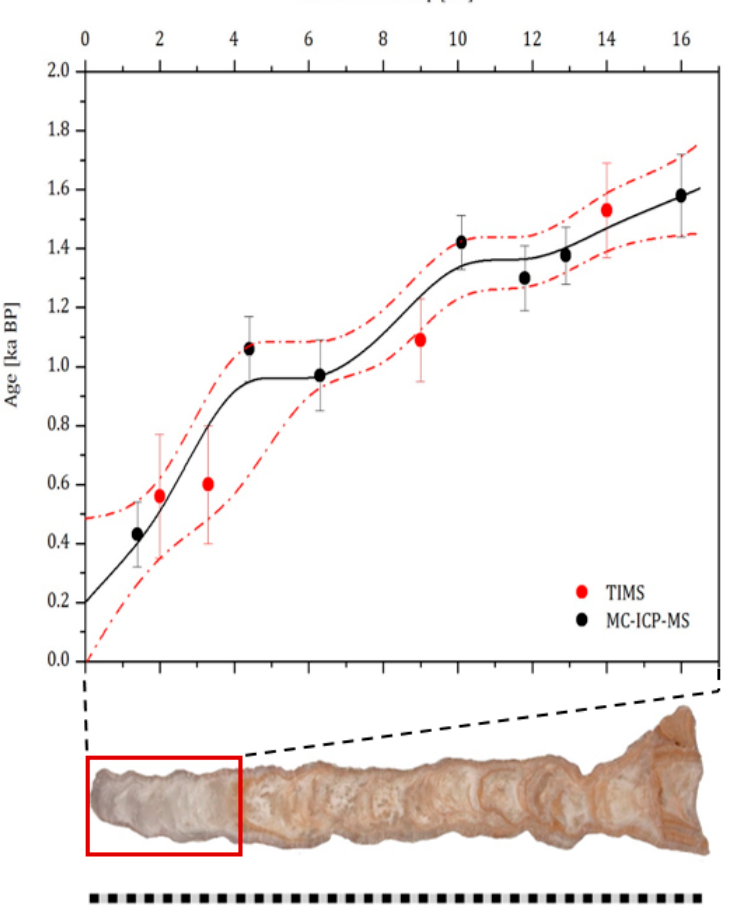
Figure 2. Age-depth model for speleothem Bu1 from Bunker Cave. Red dots indicate the ages measured with TIMS [12], the black dots indicate the new MC-ICP-MS 230 Th/U-ages measured in this study, and the dashed red lines show the upper and lower 95%-confidence limits of the age model.